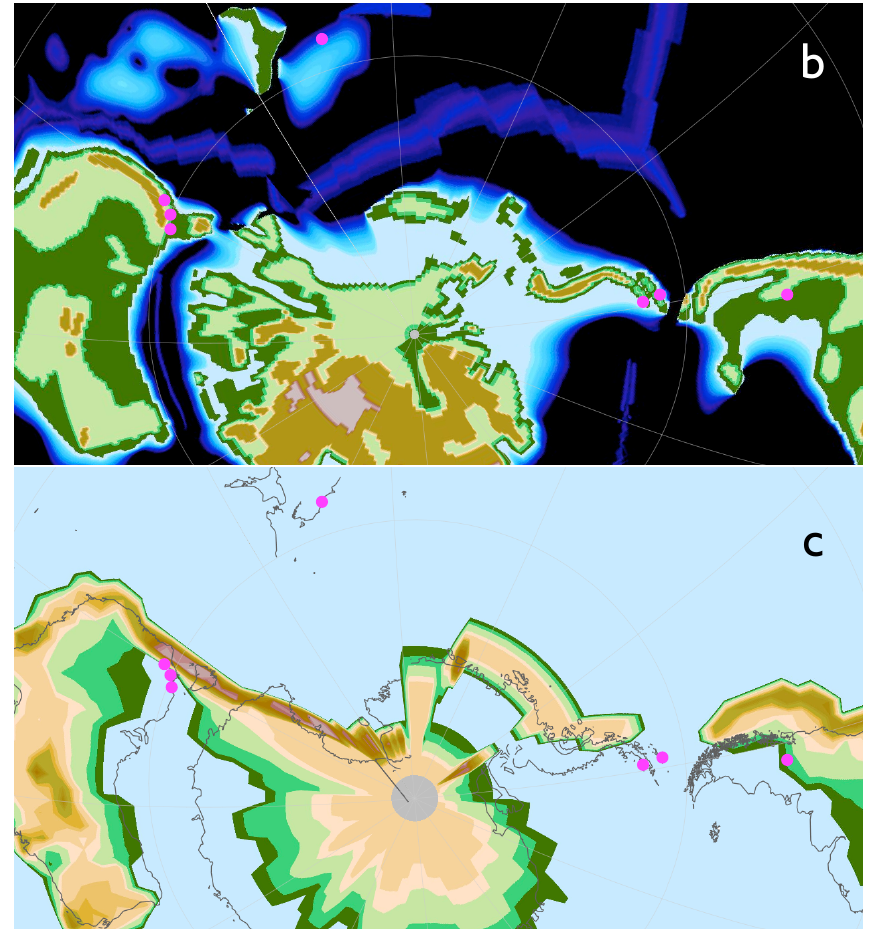
Fig. 1b − c. Figure 1 continued, see Fig. 1a for